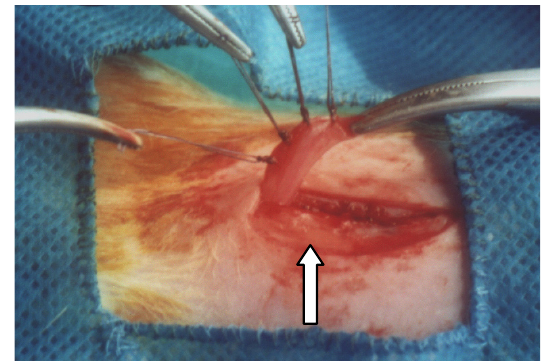
FIGURA 3 - Bexiga urinária suturada com pontos